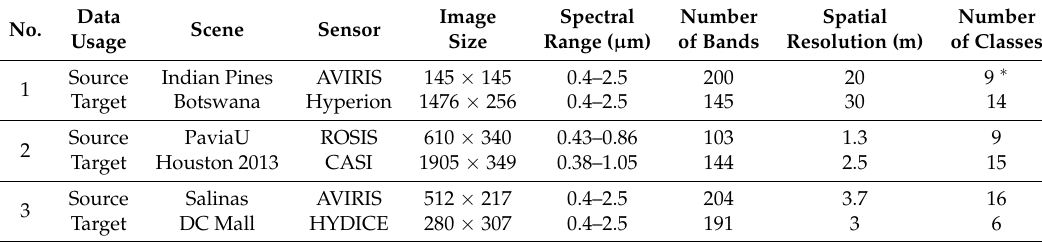
Table 1. Hyperspectral datasets used in the